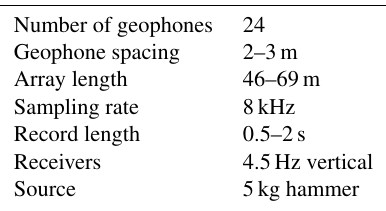
Table 1. Acquisition